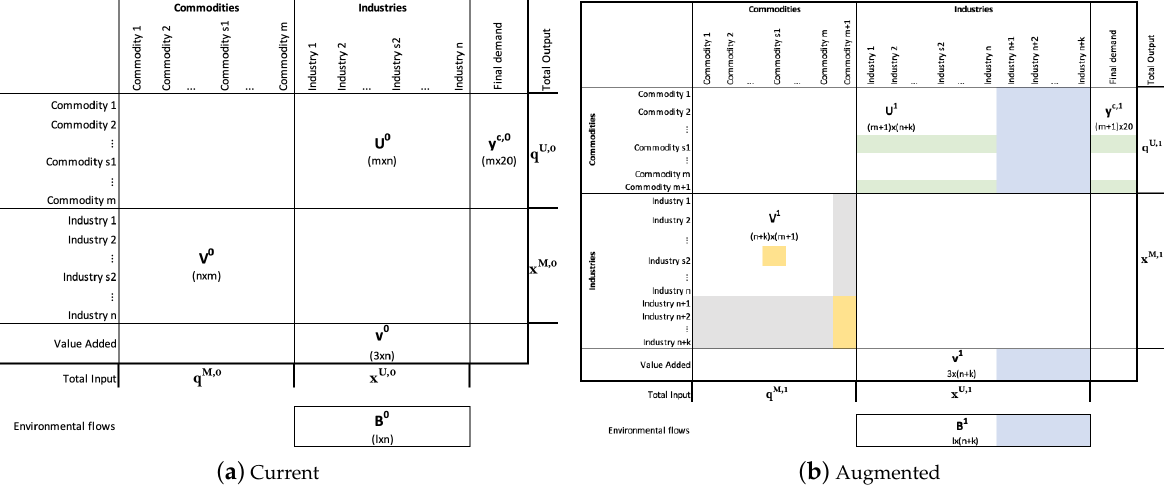
Figure 1. Structure and dimensions of the Input–Output tables based on the Make and Use tables from BEA 2012. ( a ) The current tables and ( b ) modified tables. V 0 and U 0 are the current Make and Use transactions, respectively. V 1 and U 1 are the future Make and Use transactions, respectively. In blue are new uses of the existing commodities and value added of the new industries. In green are changes in existing industry uses of commodities due to substitution in use/demand of the similar commodity. In yellow are changes in the quantity of the similar commodity produced by the similar industry as well as the quantity of the new commodity produced by new industries, and in grey are assumptions about the production of the new commodity and the new